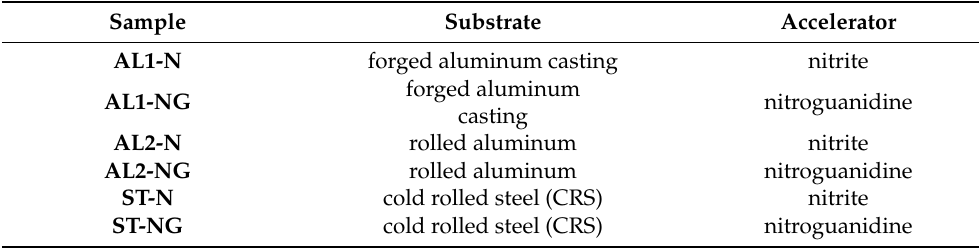
Table 3. Symbols of the phosphated